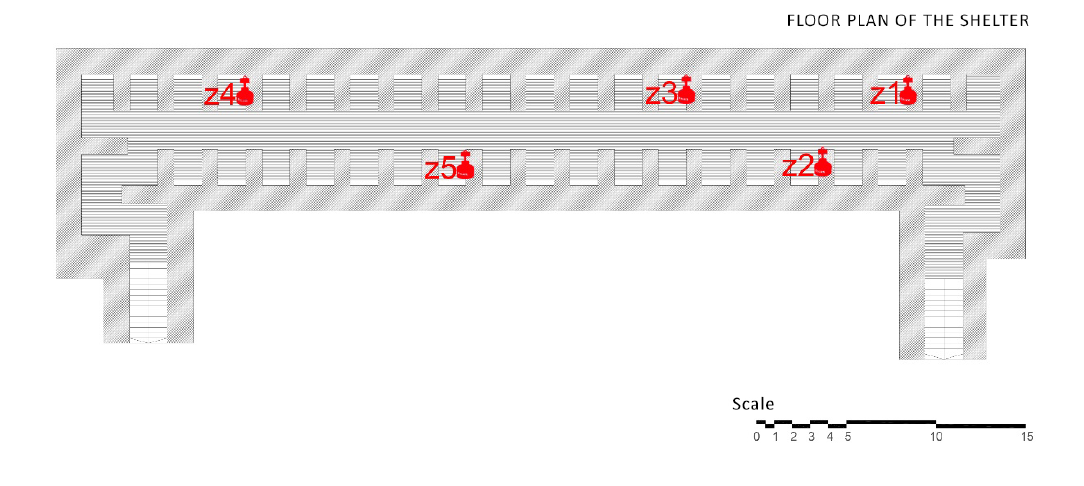
Figure 10. Measurement areas made inside the shelter in Seneca Square.